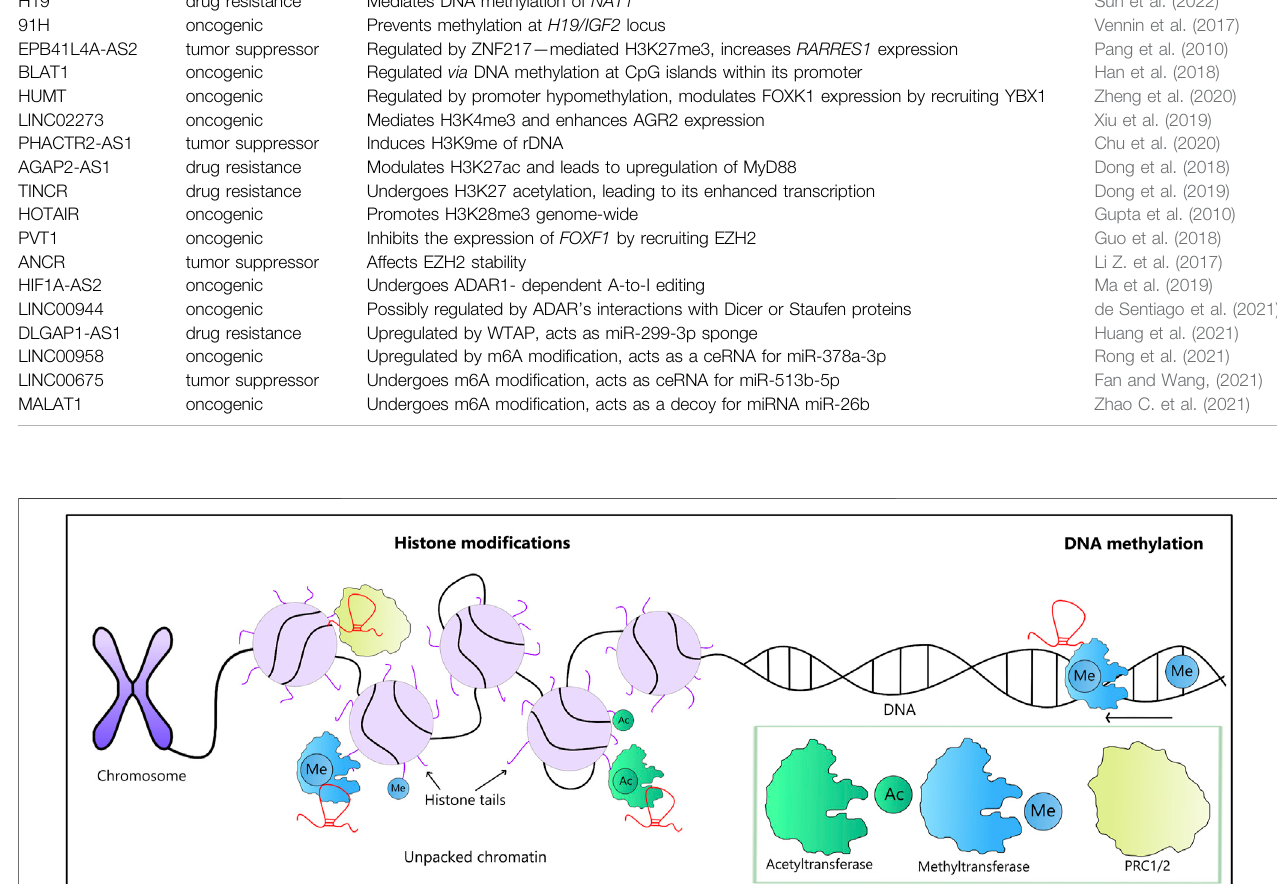
Frontiers in Cell and Developmental Biology |